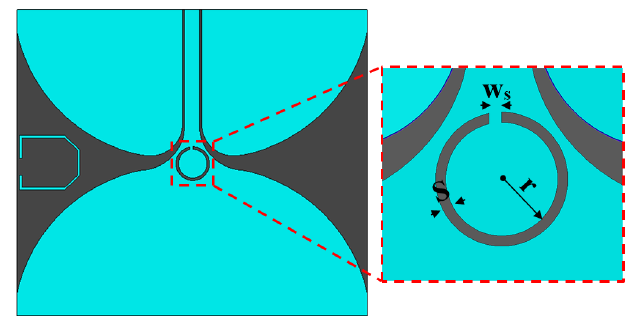
Figure 6: Proposed bi-directional antenna with dual-band notch characteristics.